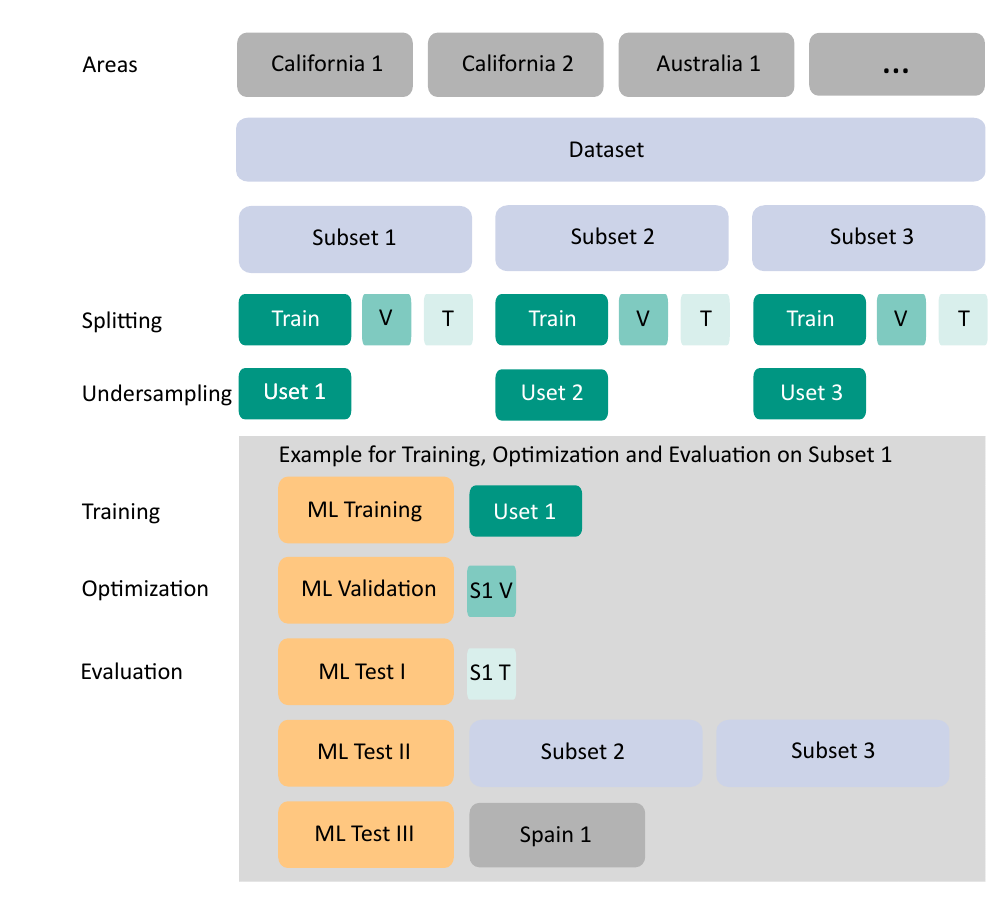
Figure 6. Flow diagram summarizing the dataset preparation applied in this study with the ML process example illustrated for Uset 1 . The following abbreviations are used: